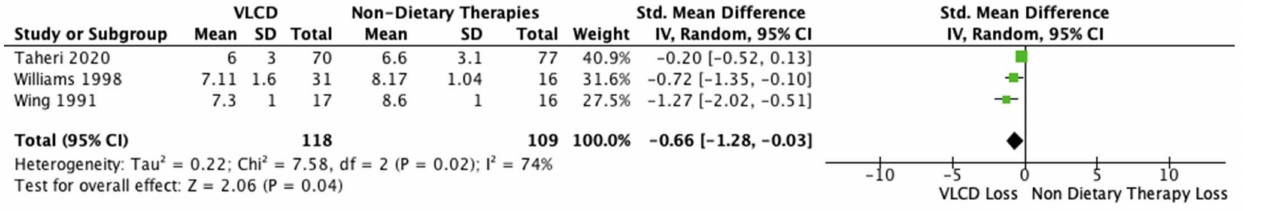
Figure 10. Forest plot comparing HbA1c levels after VLCD and non-dietary therapies